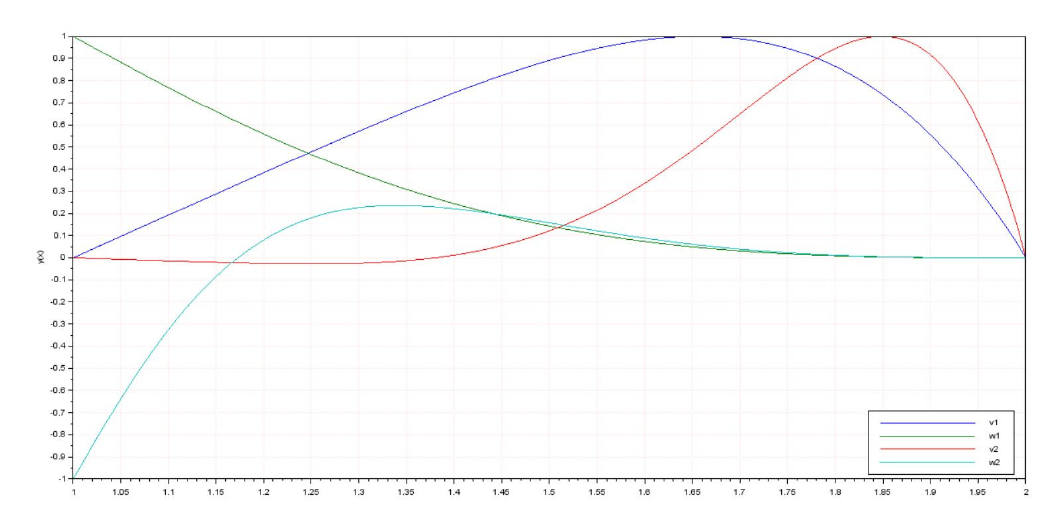
Figure 1. Eigenfunctions v 1 and v 2 and adjoint eigenfunctions w 1 and w